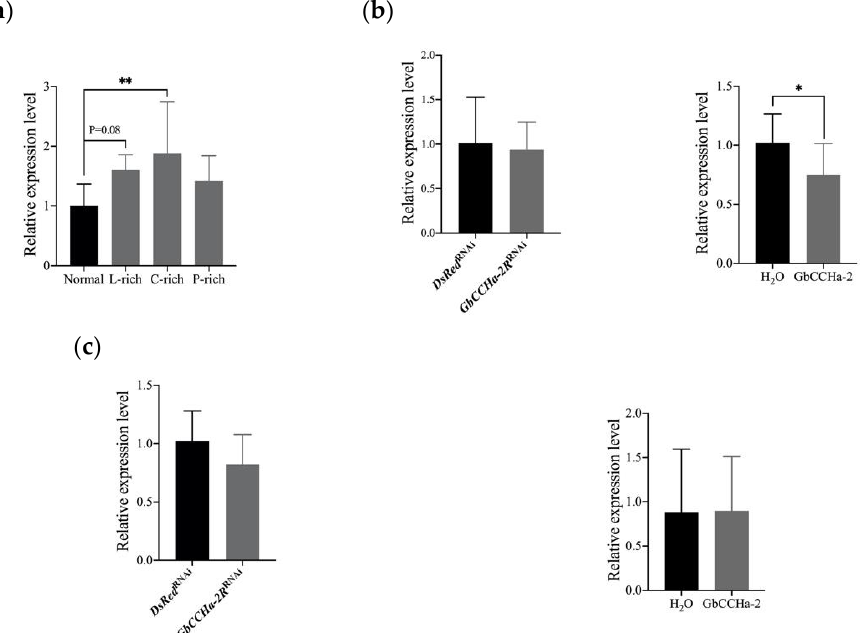
Figure 5. Effects of dietary nutrients on GbCCHa-2R and effects of GbCCHa-2 signaling on Gbilp and GbAKH : ( a ) The transcript levels of GbCCHa-2R in the crickets fed on normal diet or lipid-, carbohydrate-, and protein-rich diet (L-, C-, and P-rich); ( b ) The transcript levels of Gbilp in CNS after GbCCHa-2R knockdown and GbCCHa-2 administration; ( c ) The transcript levels of GbAKH in CNS. Values are showed as mean + S.D., n = 6–9, * p < 0.05, ** p < 0.01, one-way ANOVA with post hoc Dunnett’s test for ( a ), unpaired t -test for ( b , c